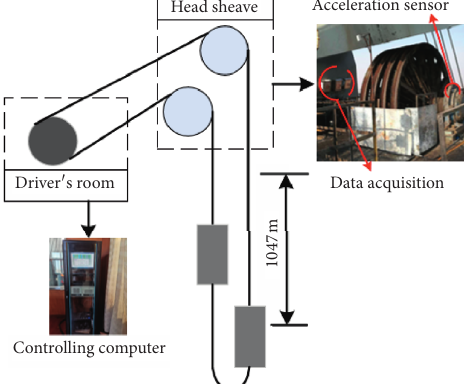
Figure 19: Installation diagram of the monitoring system.